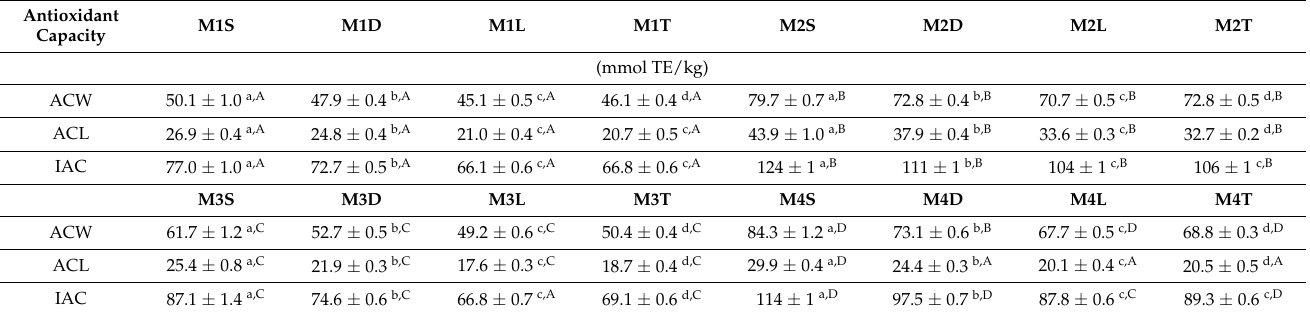
Table 7. Antioxidant activity values are determined in nutraceutical mixtures under the defined storage conditions measured using